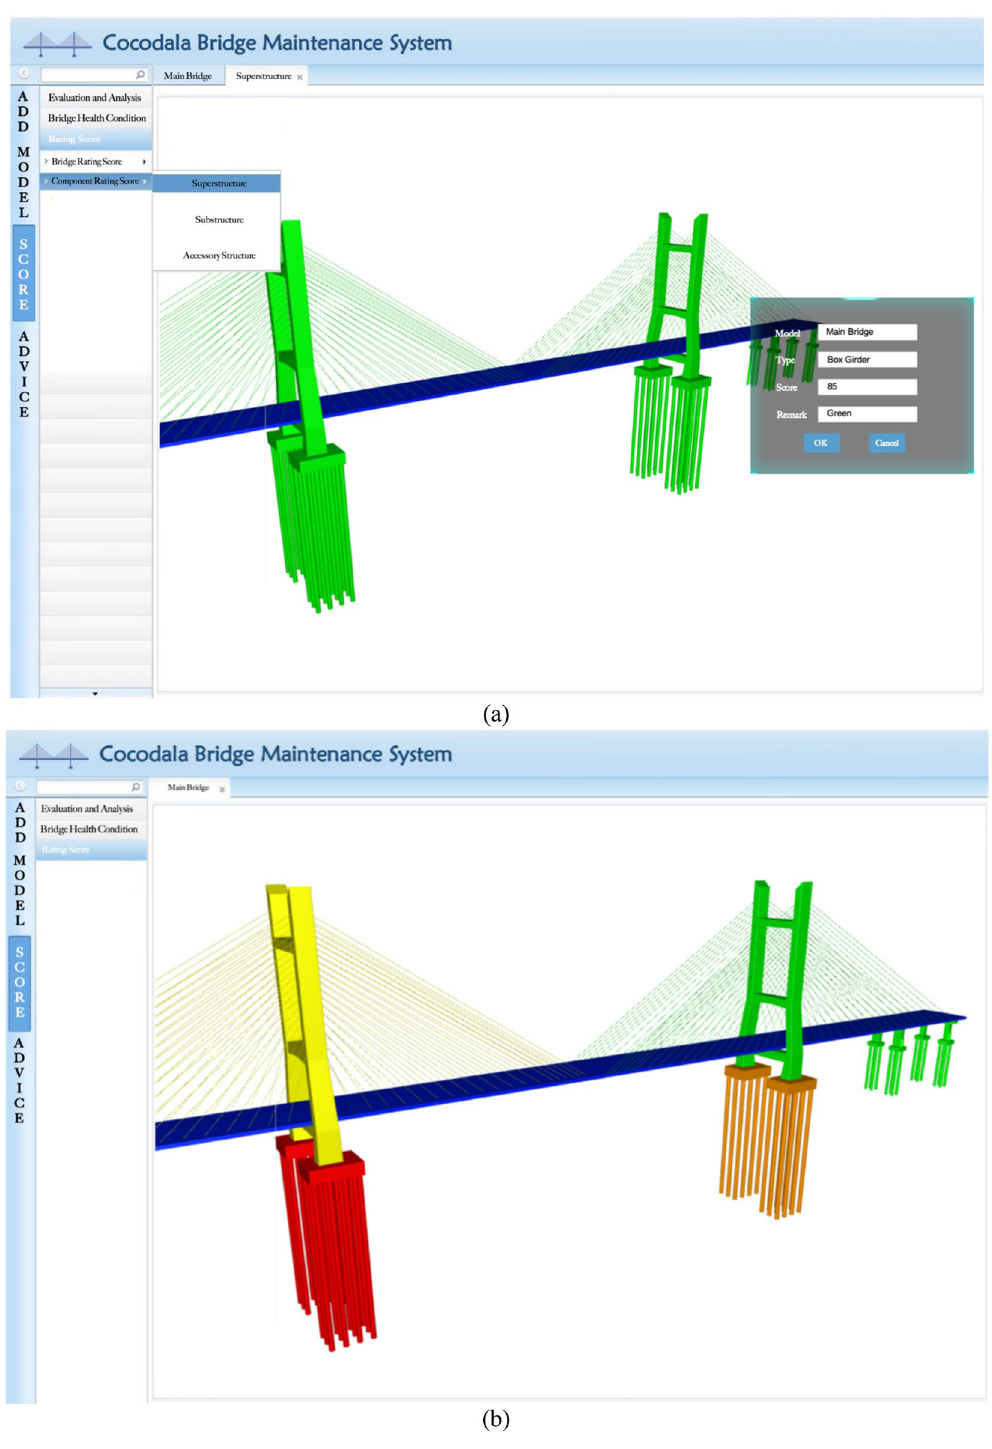
Figure 16. ( a ) Simulation colour display of 85 scores of the box girder in the bridge superstructure; ( b ) Simulation colour display of the overall score of the